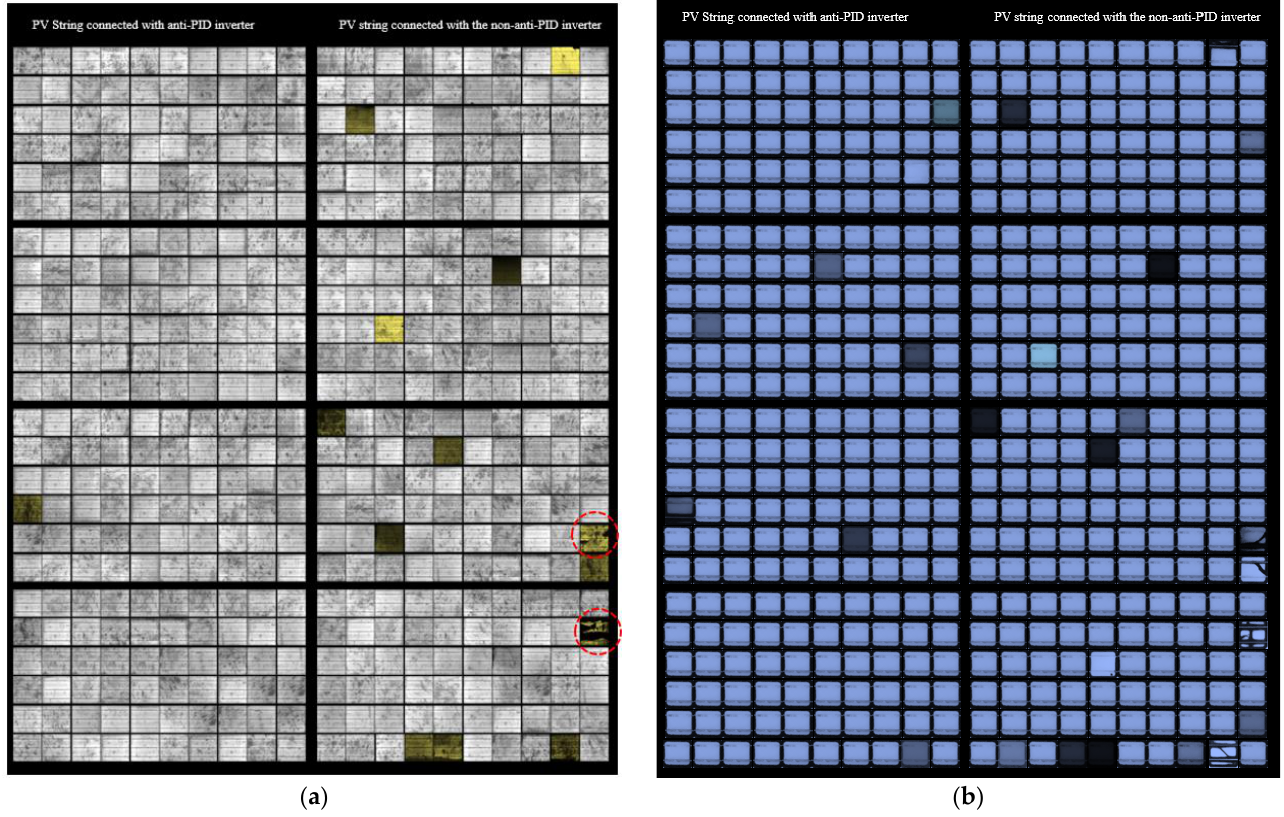
Figure 5. Inspection of the PV modules after three years of field service: ( a ) EL image, ( b ) UVF image. Those solar cells labeled in "red" have some major cracks.